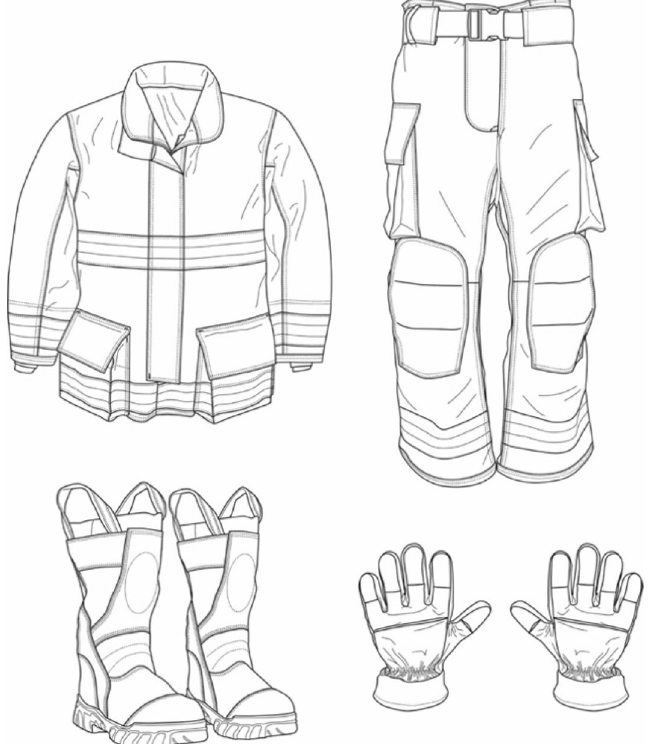
Fig. 1 Typical cut and sewn Personal Protective Equipment worn by